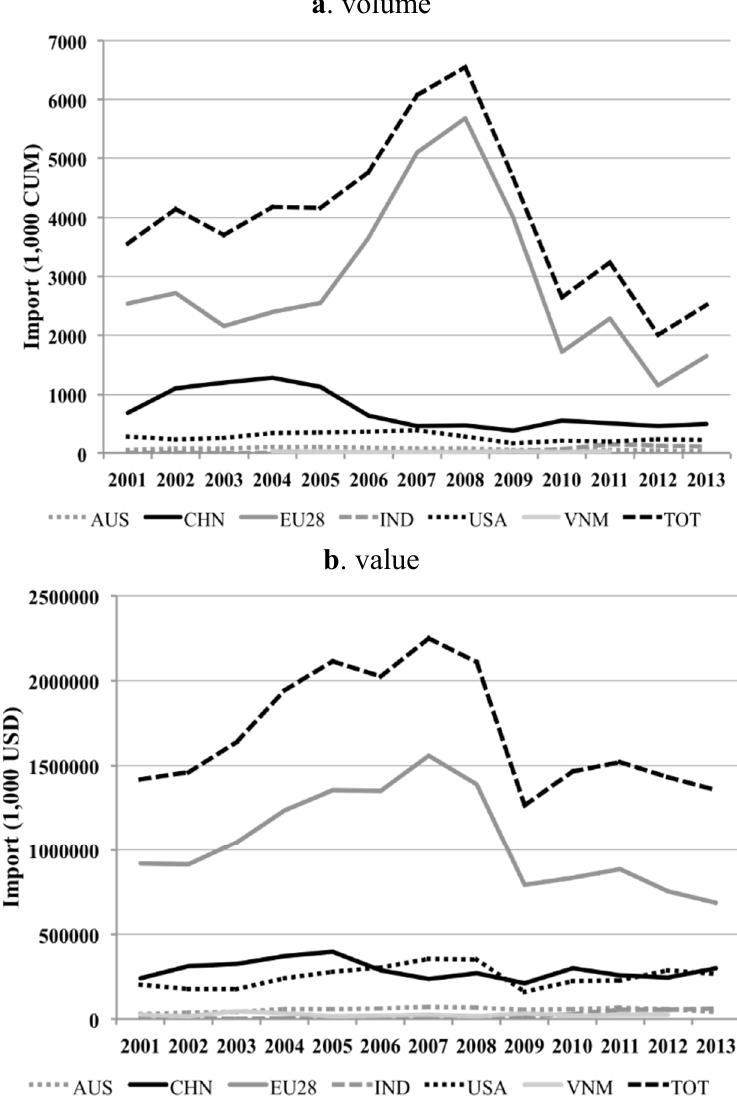
Figure 3. Imports of tropical sawnwood—in volume ( a ) and value ( b )—by selected countries (2001–2013). Source: own elaboration from